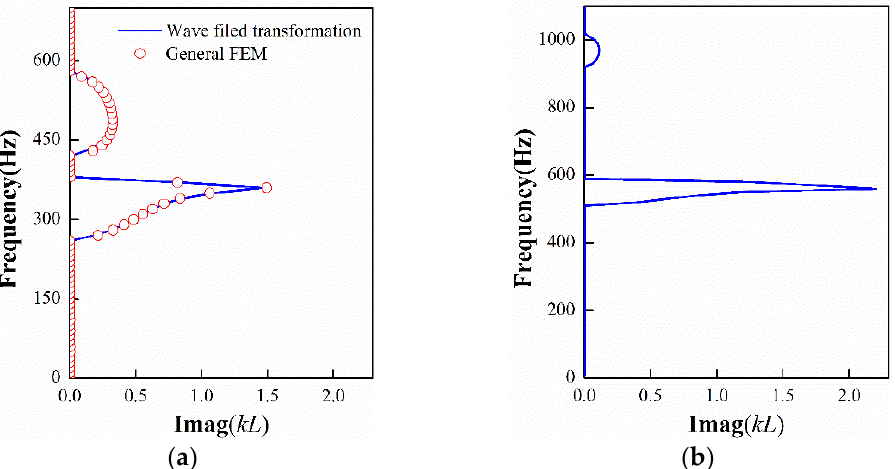
Figure 6. Attenuation constants versus excitation frequencies for the phononic plate in the case of θ = 0: ( a ) with fluid loading; ( b ) without fluid loading.